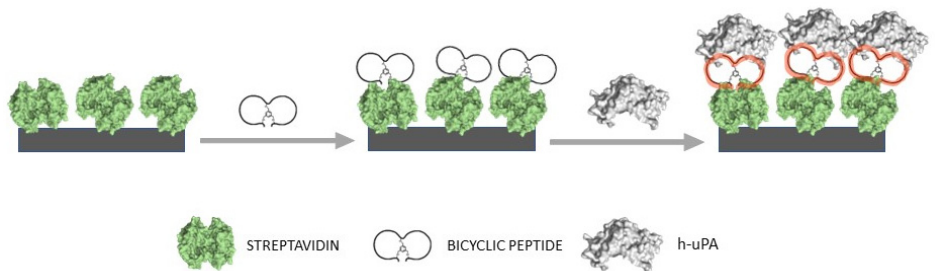
Figure 2. Schematic representation of the assembling procedure of the bicyclic peptide-based impedimetric platform for h-uPA detection.